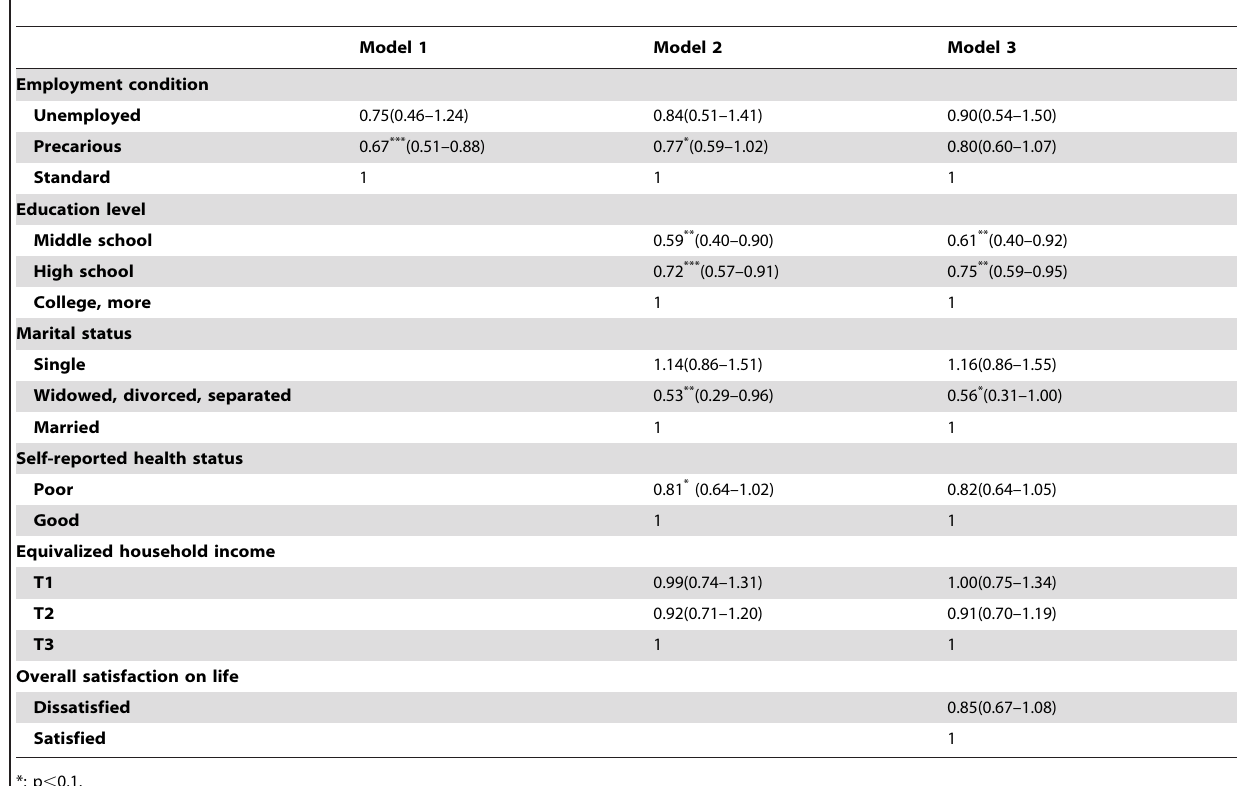
Table 4. Adjusted odds ratios a (95% confidence interval) of quitting smoking according to employment status among 2005 or 2006 smokers